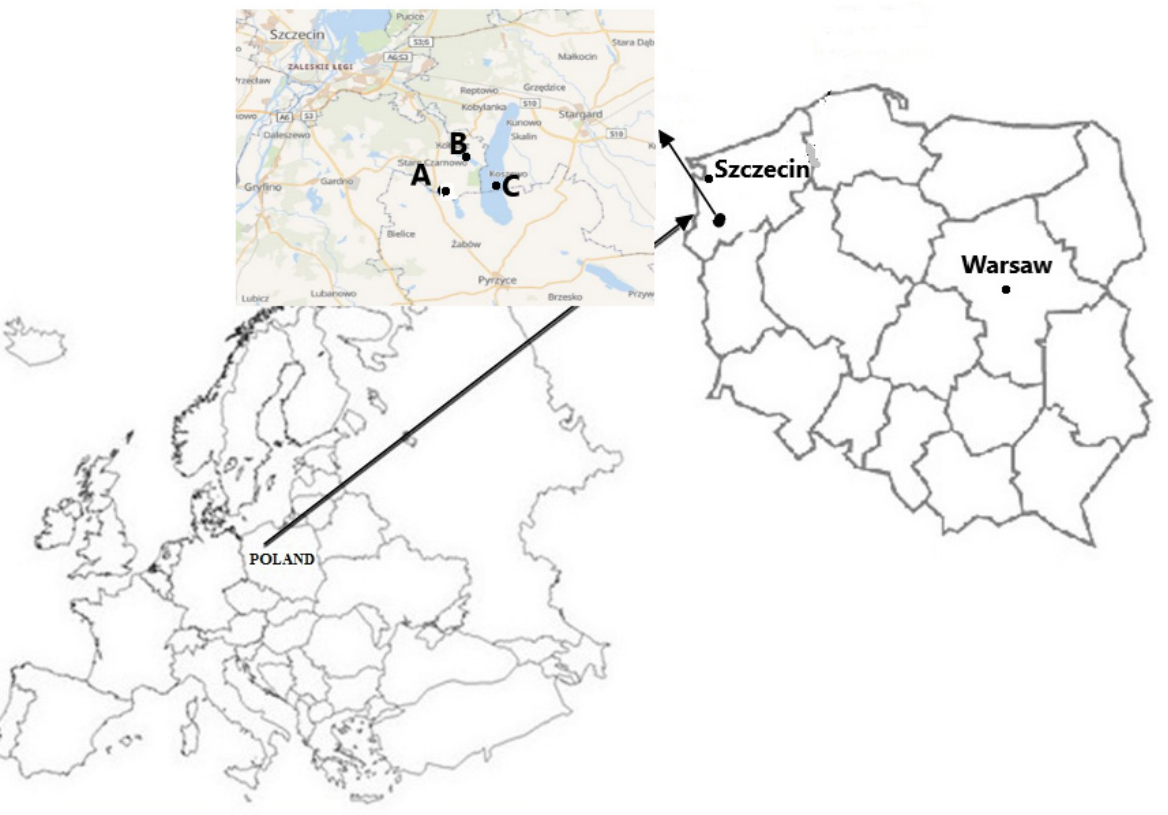
Figure 1. Location of the study area. Notes: A—P ł o ń Lake; B— Ż elewko Lake; C—Miedwie Lake.